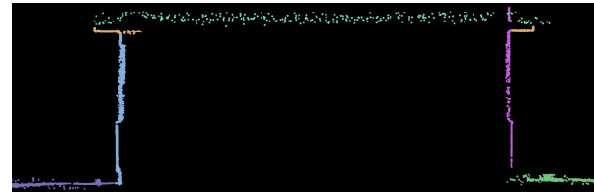
Figure 9: A cross section of a structure showing the segmented terrestrial and airborne